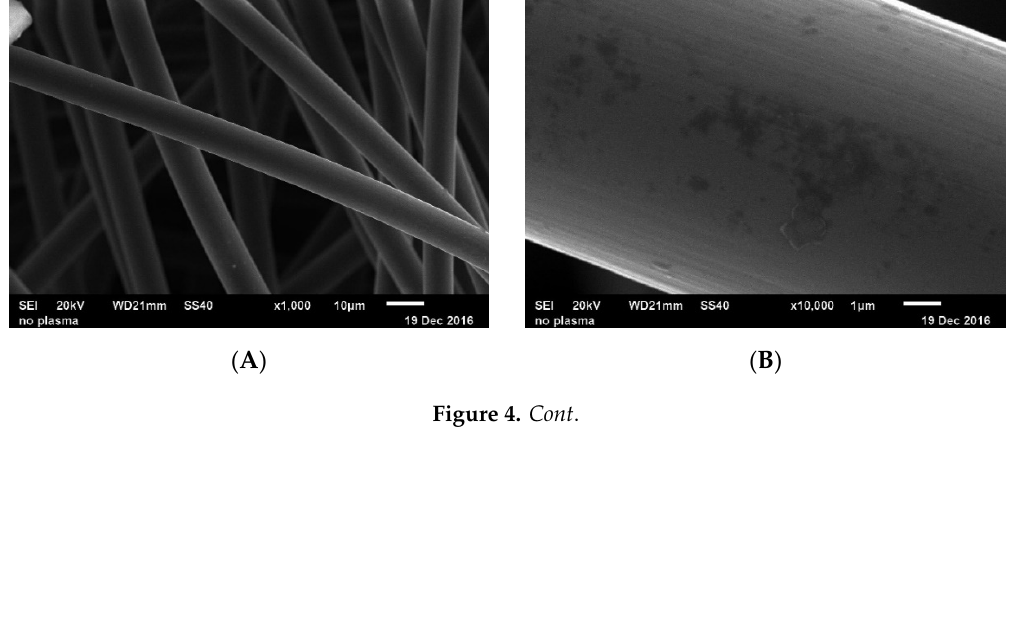
( F ) Figure 4. The SEM images of the pristine felt in ( A ) 1000 times zoom and ( B ) 10,000 times zoom; the atmospheric plasma treated felt in ( C ) 1000 times zoom and ( D ) 10,000 times zoom. The TEM images of ( E ) the pristine felt and ( F ) the atmospheric plasma treated felt. 3.3. BET Surface Area Analysis